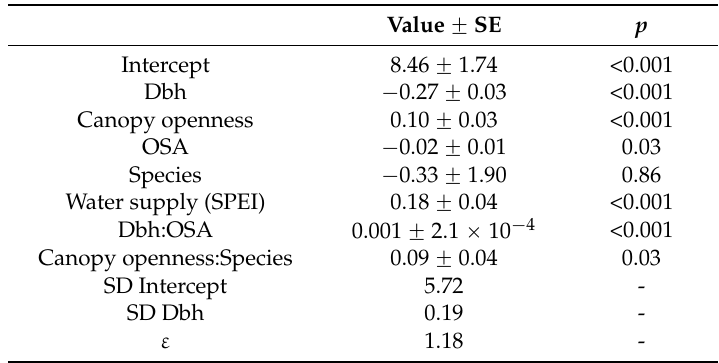
Table 3. Linear mixed model on the annual growth rate (mm ∙ year − 1 ) during the last 20 years (1994– 2013) of all analyzed trees (response variable) with the individual tree code as random effect and a random slope added for the effect of dbh, and fixed effects dbh, canopy openness, OSA, species, and water supply (measured with SPEI) of the form: Growth rate ij = β 1 × x 1 ij + … + β n × x nij + b i 1 × z 1 ij + … + b in × z nij + ε ij where the growth rate is the response variable for the j th of n i observations in the i th of M groups or clusters, β 1 , …, β n are the fixed ‐ effect coefficients, which are identical for all groups, x 1 ij , …, x nij are the fixed ‐ effect regressors for observation j in group i ; the first regressor is usually for the constant, x 1 ij − 1 , b i 1 , … b in are the random ‐ effect coefficients for group i , z 1 ij , …, z nij are the random ‐ effect regressors, and ε ij is the error for observation j in group i .